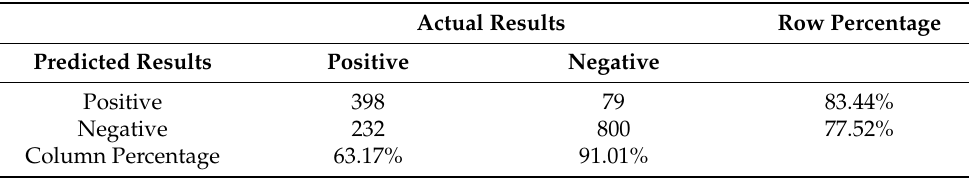
Table 9. SVM classifier result